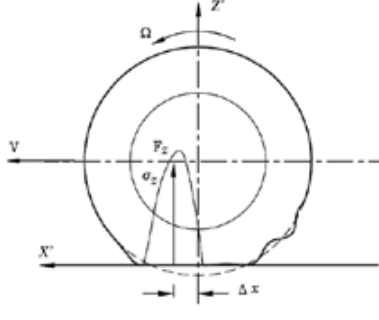
Fig. 1. Distribution of the normal pressure in the tyre-road contact zone